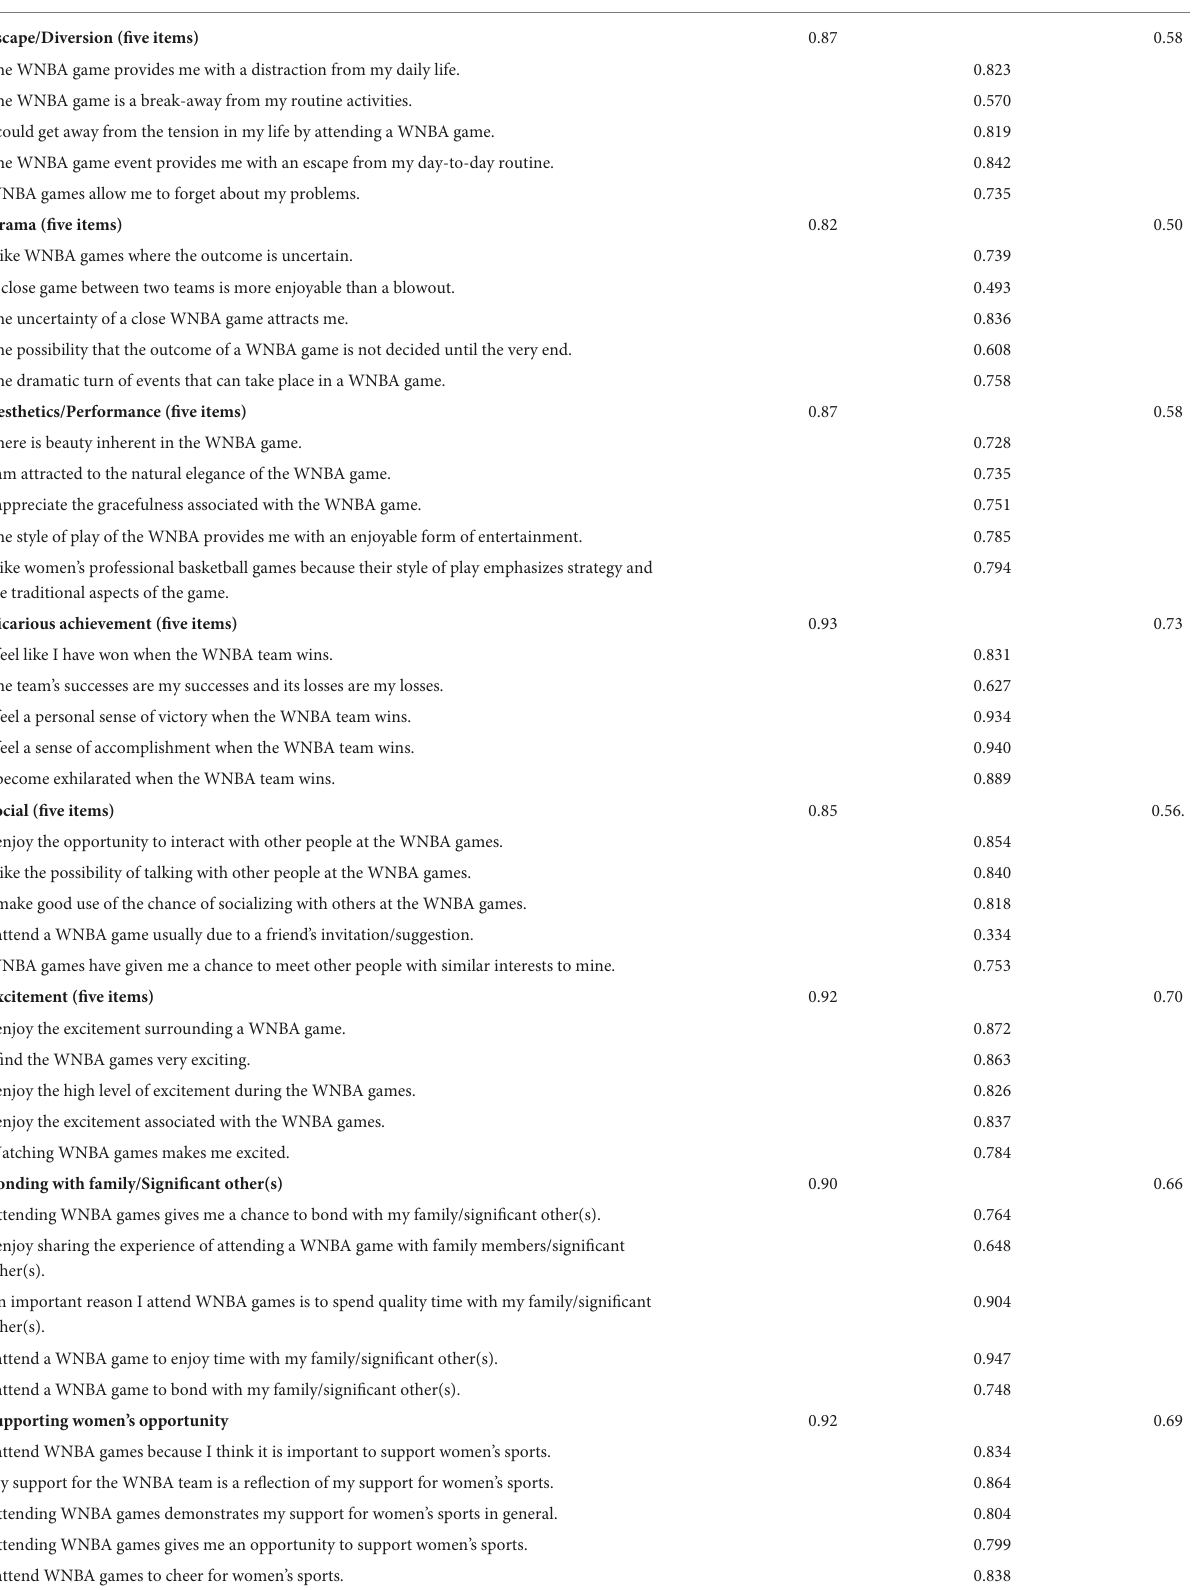
TABLE 1 Summary results for measurement model of push factor. Construct and items CR λ